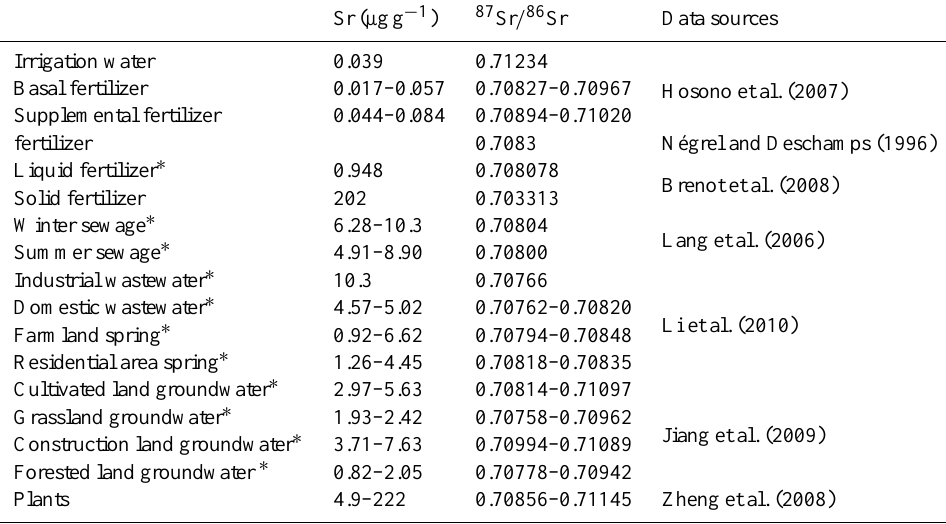
Table 5. Sr isotopic compositions of fertilizer, wastewater, groundwater, and plant in different land use patterns in karst